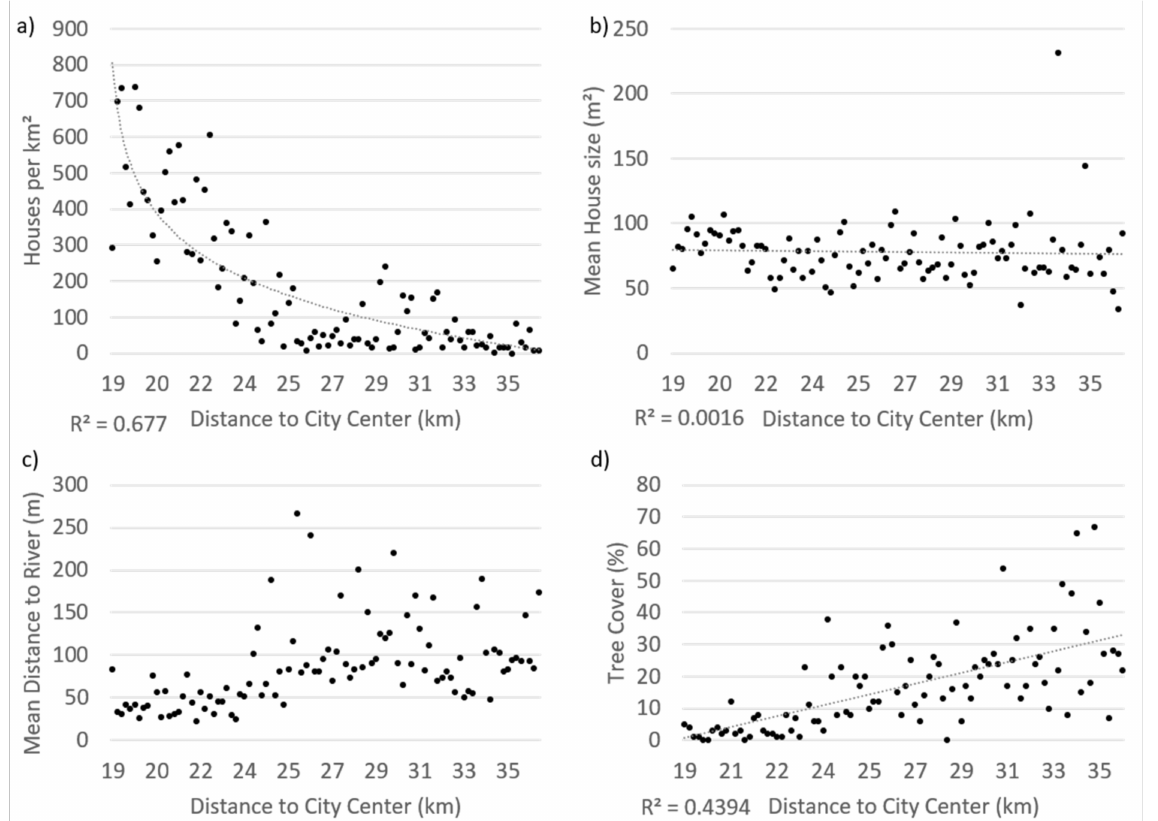
Figure 7. Distribution of values along a peri-urban gradient with trend lines for the following categories ( a ) decreasing houses per km 2 with distance to city center, ( b ) constant house size, ( c ) random mean distance to river (m), and ( d ) increasing tree cover (%) with distance to city